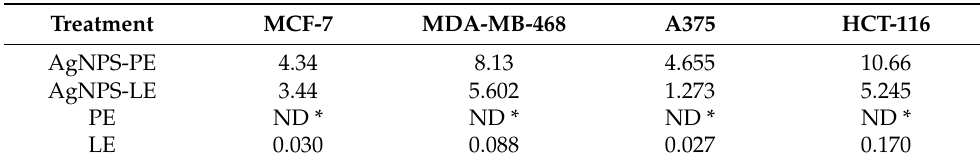
Table 2. Therapeutic indexes ( µ g/mL) for AgNPs-PE, AgNPs-LE, PE and LE in different tumor cell lines compared to the macrophage cell line. * ND (not determined).